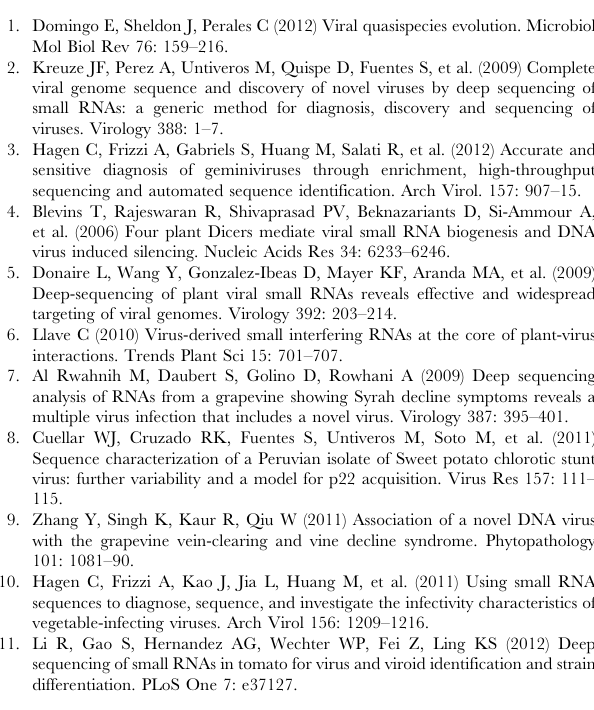
Dataset S3 SNPs in viral and viroid quasispecies. Table S3A : SNPs at positions of the mismatches between the reconstructed wild-type ORMV genome and the original ORMV genome clone as well as SNPs in the wild type ORMV viral quasispecies; Table Table S3D : SNPs in CaLCuV DNA-B; Table S3E : SNPs at the positions of the mismatches between the GVGV-Oregon and the GVGV-New York genomes as well as other SNPs in the GVGV- Oregon quasispecies; Table S3F : SNPs in the GYSVd-1 (red) and green) quasispecies; Table S3G : SNPs in the GYSVd-1 (green) quasispecies; Table S3H : SNPs in the HSVd quasispecies. (XLSX) Dataset S4 Analysis of the contigs generated by Velvet and Oases using non-redundant 20–25 nt sRNA libraries from CaMV (BPO-20 and BPO-21)-, CaLCuV (BPO-57)- and ORMV (BPO38 and BPO44)-infected Arabidopsis . Coverage (in %) of the viral genome sequences with the siRNA contigs is calculated for single k-mer values and combination